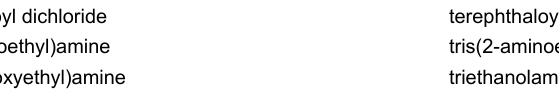
Table 1: Organic compounds (and their different names and abbreviations) employed in MLD and ALD/MLD processes together with vapor pres- sures, P , at 100 °C and temperatures, T , corresponding to a vapor pressure of 2 mbar for some of the organic precursors (the values were calculated by using the equations and parameters obtained from the DIPPR Project 801 database (full version) [58]). (continued) terephthaloyl dichloride